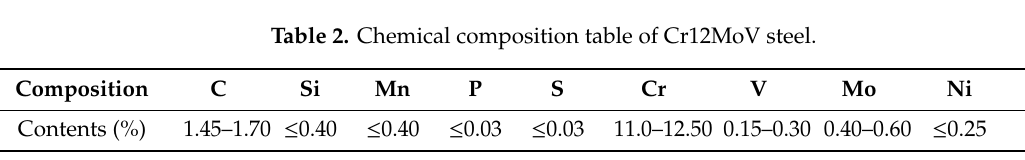
Figure 9. Topography simulation results of the machined surface. ( a ) Residual height z of the machined surface; ( b ) three-dimensional image of the machined surface.